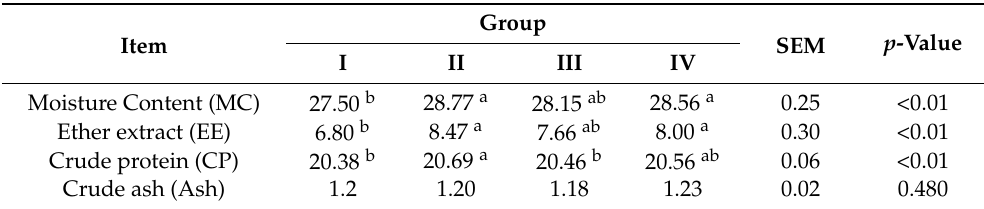
Table 6. Effect of different processing modes of mulberry leaf TMR diet on the nutrient composition of black goat muscle (air-dry matter basis,